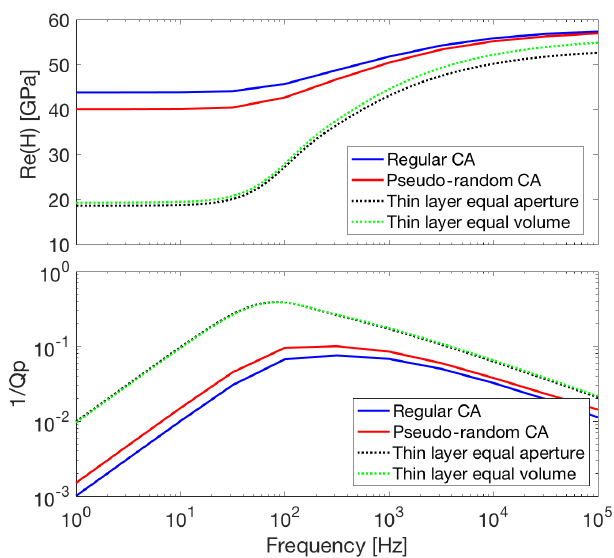
Figure 4. Real part of the vertical ( z ) component of the total stress field at the centre of the fractures illustrated in Fig. 2 at 1Hz (a, b) and at 100kHz (c, d)